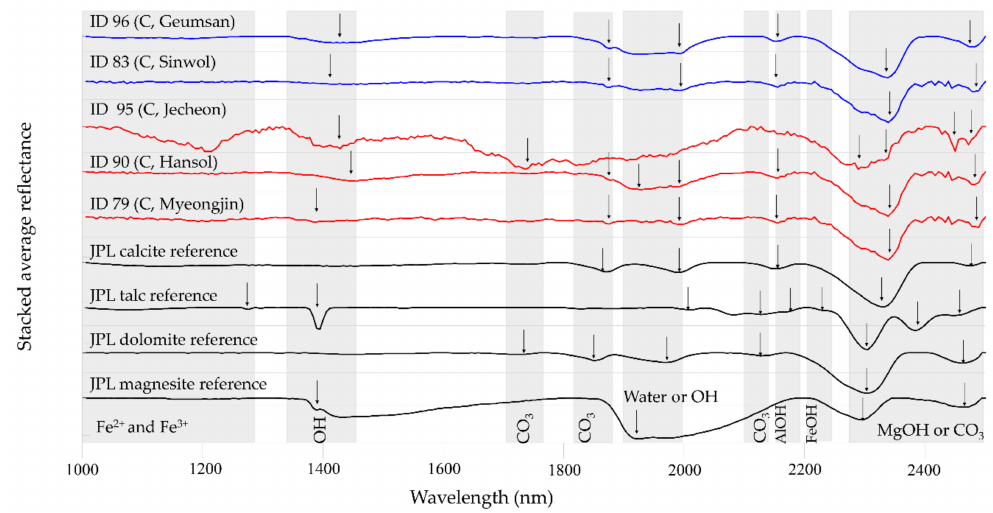
Figure 3. The average hull quotient corrected reflectance spectra of 2 groups of calcite sample pixels (red = group 1; blue = group 2) compared with library reference